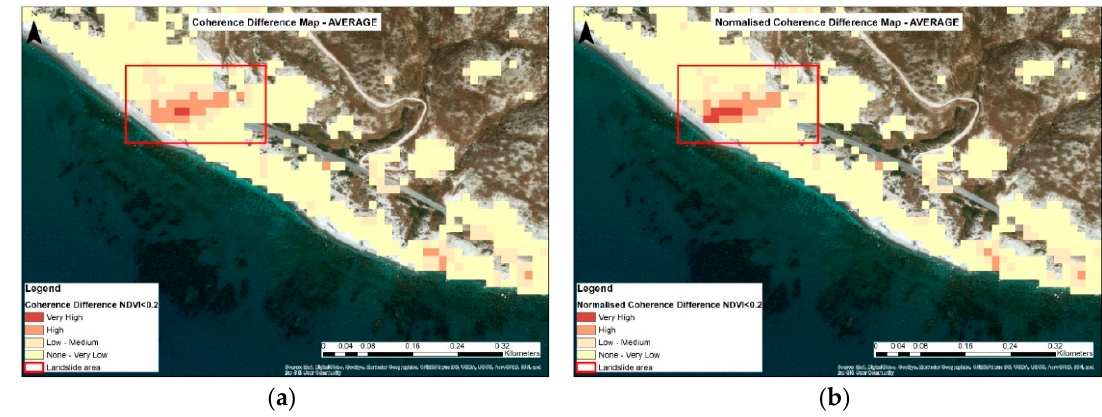
Figure 24. ( a ) Coherence difference and ( b ) normalized coherence difference maps – Average.